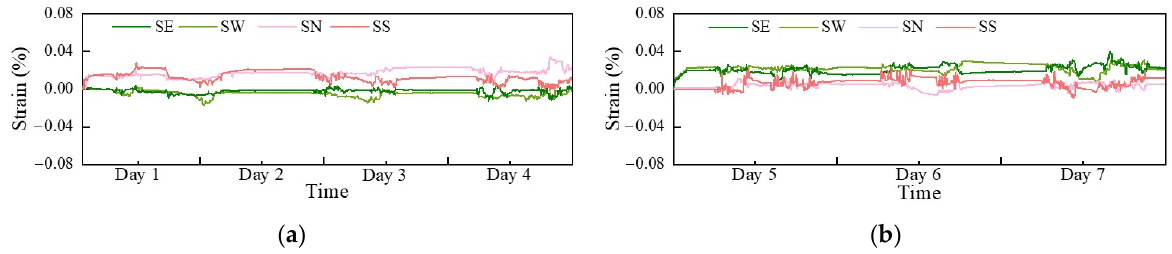
Figure 10. Strain variations during the ( a ) westward and ( b ) northward movement.